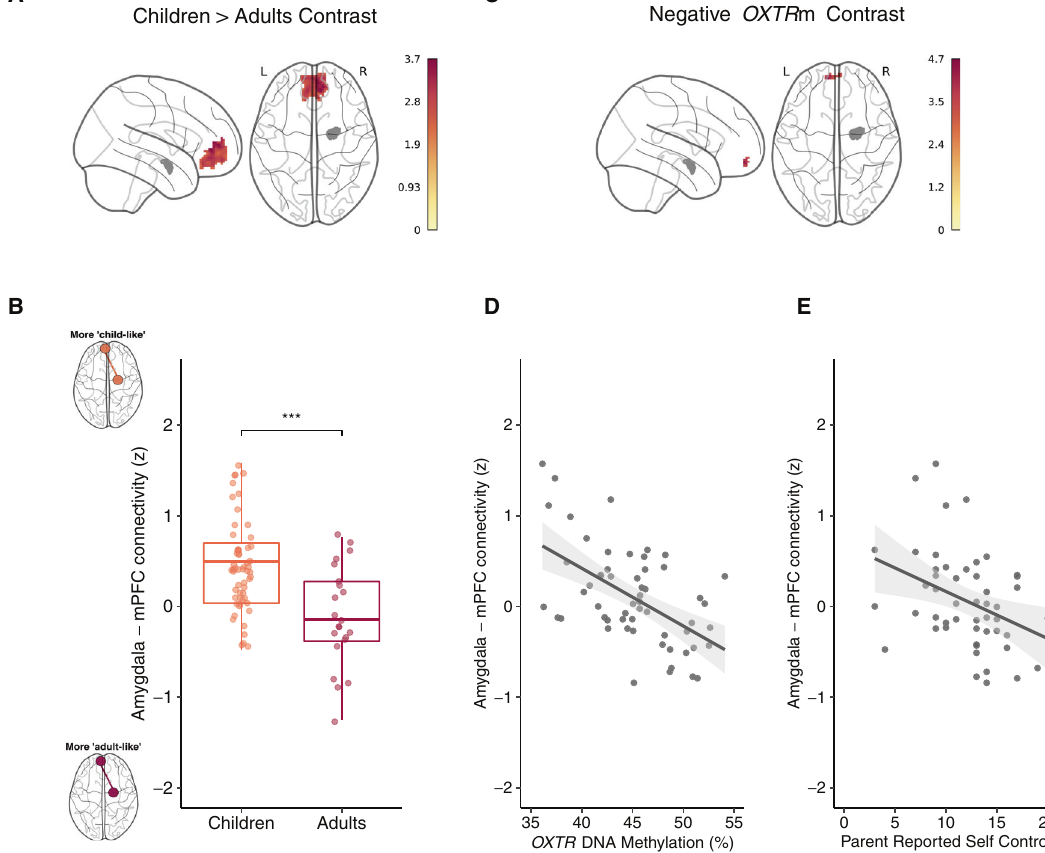
Fig. 1 Adults show reduced right amygdala – mPFC functional connectivity compared to children. Children with increased methylation of OXTR display reduced right amygdala-mPFC functional connectivity. A Z statistic map of voxels shows the signi fi cant main effect of age group (Children > Adults) in MNI space. The right amygdala seed region is depicted in gray. B Mean Z statistic values are plotted for each individual in the child cohort ( n = 57) and adult ( n = 23) cohort. *** P < 0.001. C Z statistic map of voxels shows the signi fi cant negative main effect of OXTR m depicted in MNI space. The right amygdala seed region is depicted in gray. D Mean Z statistic values are plotted against percent OXTR m for each participant ( n = 57). Gray shading indicates 95% con fi dence interval around the best- fi t line. E Mean Z statistic values are plotted against parent-reported self-control scores for each participant ( n = 50). Gray shading indicates 95% con fi dence interval around the best- fi t